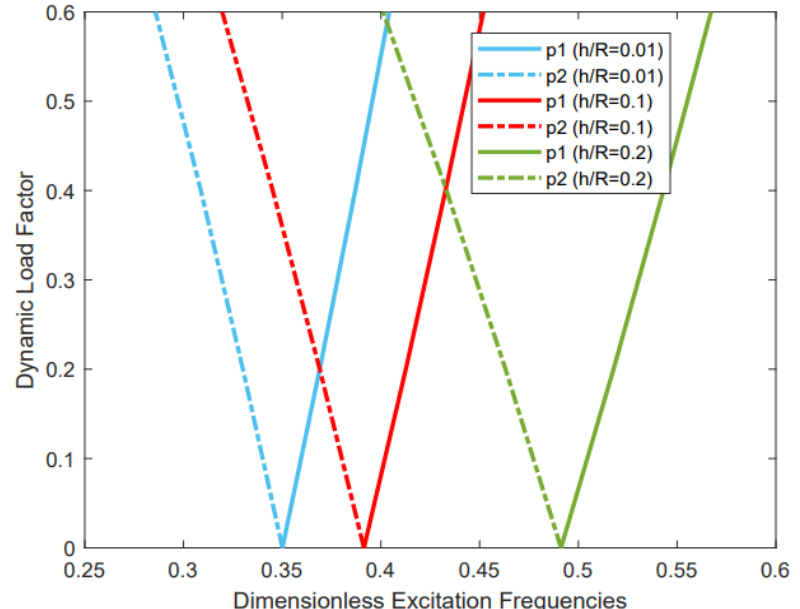
Figure 7. The effect of the h/R ratio.